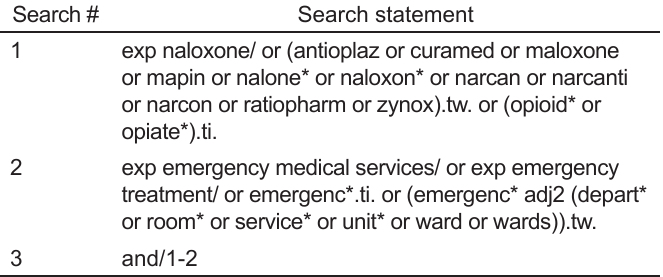
Table 1. Literature search strategies regarding naloxone access for the three Ovid MEDLINE